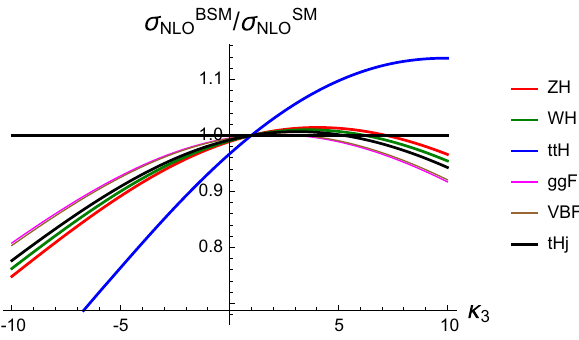
/σ SM Fig. 11 σ BSM asafunctionof κ 3 for gg F(purple),VBF(brown), NLO NLO W H (green), Z H (red), t ¯ tH (blue), and tHj (black) at 13 TeV